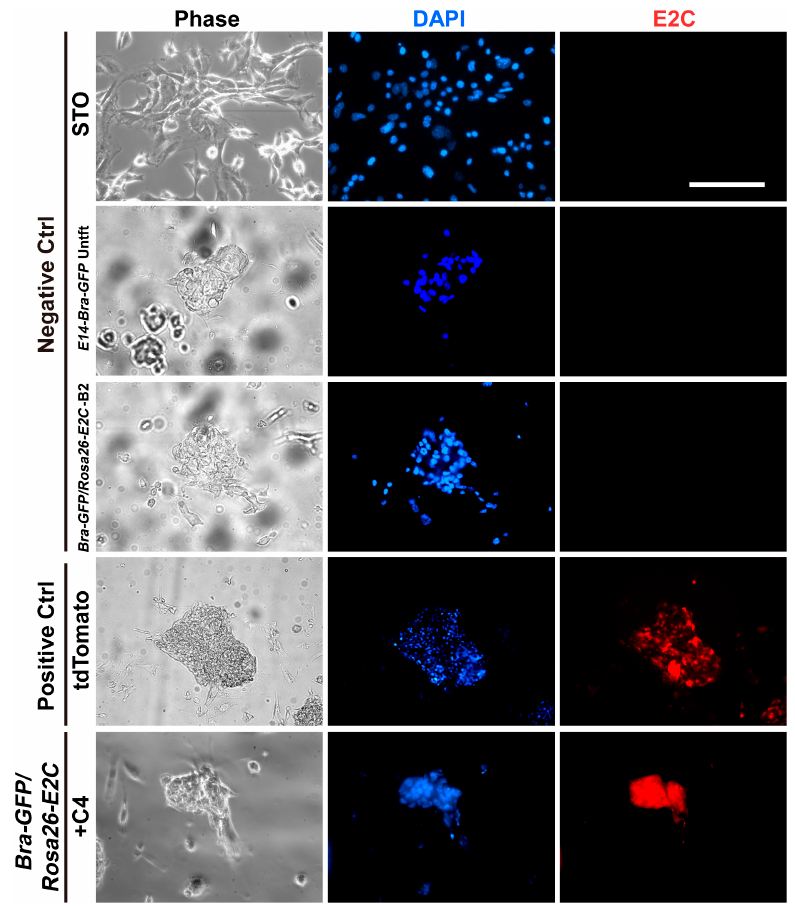
Figure 2. E2C expression was examined by fluorescence microscopy in 3 ′ -HA PCR-screened positive and negative clones. Fluorescence signal was detected within the positive clone named +C4.